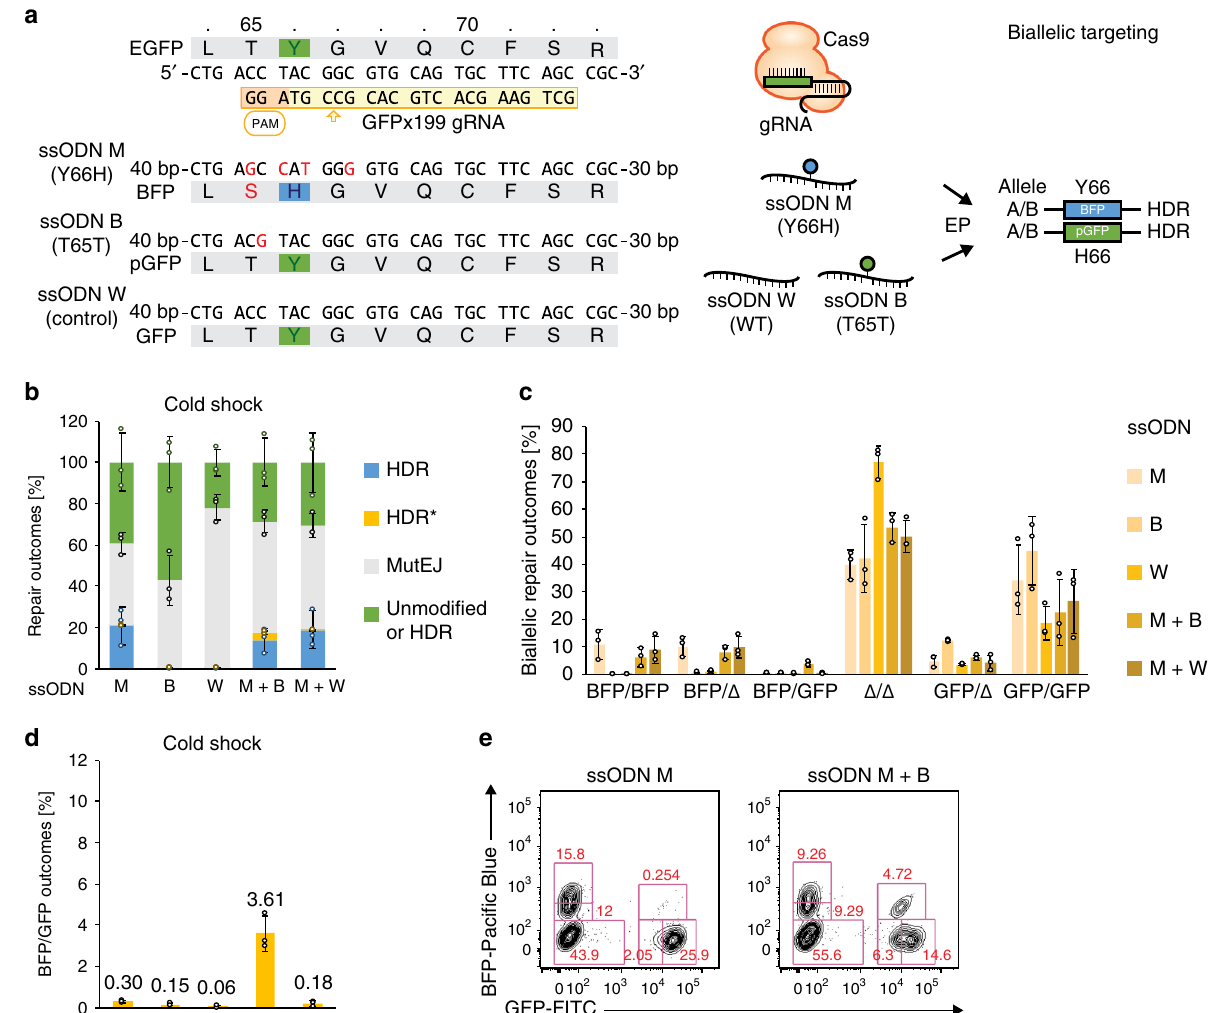
Fig. 5 Generation of heterozygous mutations requires protection of one allele. a Target sequence in the GFP reporter, and ssODN repair templates to create a missense Y66H mutation (ssODN M), a silent T65T blocking mutation (ssODN B) or no mutation (ssODN W). HDR repair of ssODN B T65T results in a protected GFP (pGFP) allele. Cells bearing unmodi fi ed or pGFP alleles are indistinguishable by FACS and are scored cumulatively as GFP. b GFP editing with ssODN M, B or W individually, or in M + B and M + W combination, and effect on DNA repair outcome frequency under cold shock condition. HDR* indicates the frequency of heterozygous double-positive BFP/GFP or compound heterozygous double-positive BFP/pGFP repair outcomes. GFP- positive cells include unmodi fi ed cells and HDR-mediated monoallelic pGFP/GFP, pGFP/indel ( Δ ), or biallelic pGFP/pGFP repair outcomes. c Distribution of biallelic repair outcomes shown in b . d Biallelic BFP/GFP repair outcome frequency measured in c . e Representative FACS plots of BFP conversion only (ssODN M) or heterozygous compound BFP/pGFP mutations (ssODN M + B). All data are presented as the mean ± S.D. of three technical replicates of independent electroporations for each respective condition. Source data are provided as a Source Data fi